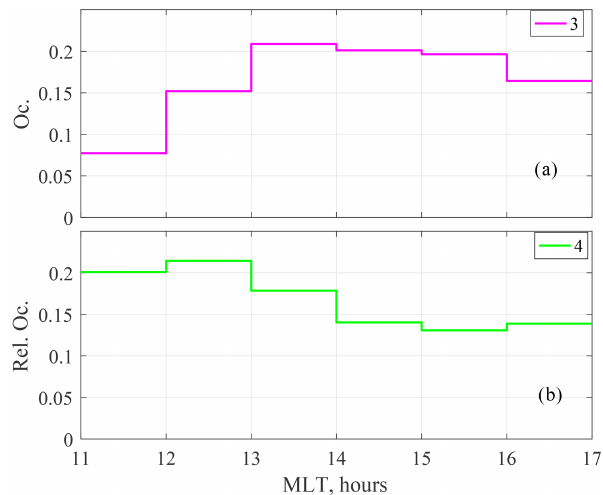
Figure 9. (a) The average MLT distribution of occurrence of (cid:49) fo F2 intervals (group 3); (b) relative occurrence of coherent (cid:49) fo F2- b X pulsations (group